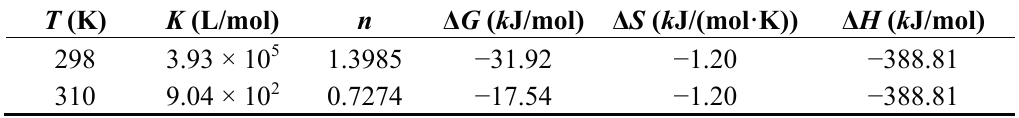
Table 2. Binding parameters and thermodynamic parameters of LYS to GA interaction system. T